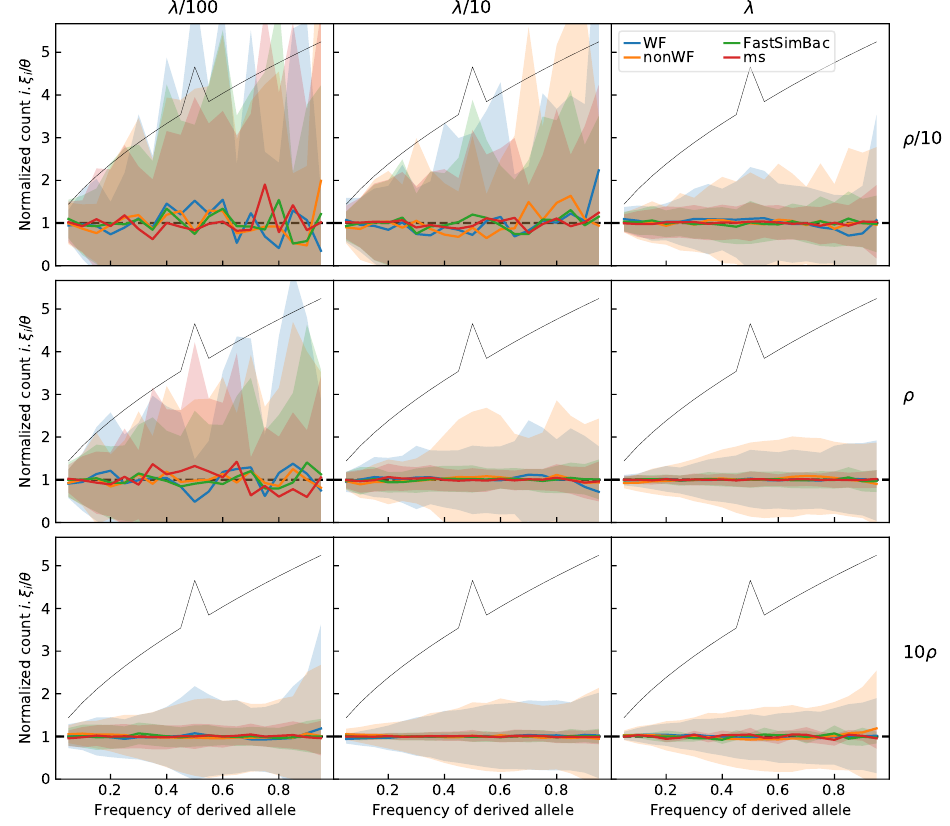
Figure 5 – The normalized Site Frequency Spectrum (SFS) for different recombination rates ( ρ ) and tract lengths ( λ ). The colored shaded areas represent standard deviation. The horizontal line at 1 is the expected normalized SFS and the black line represents the expected standard deviation, both under the WF model without recombination. Param- 10 − 9 ; λ = 122 kb ; Ne = 140k; 30000 eters used: chromosome size = 2Mb; µ = ρ = 1 . 53 × generations; RF=25. The observed SFS matches the expected horizontal line in all cases. Under low recombination their standard deviations also match the expectation, but the variance decreases with the recombination rate in accord with theoretical